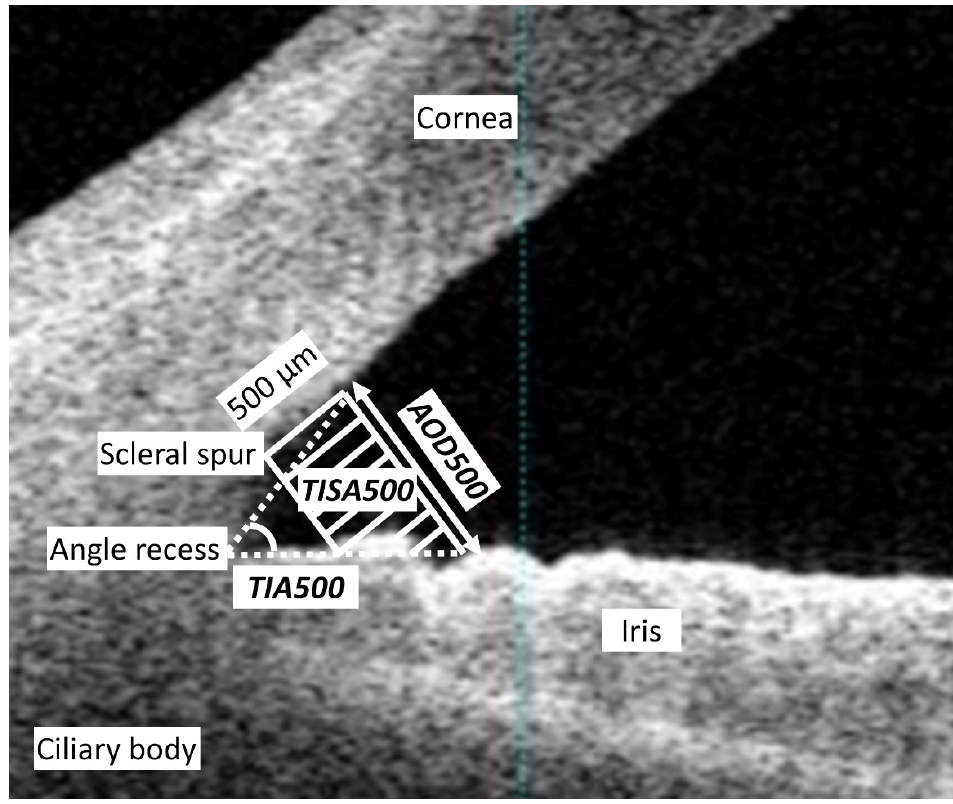
Figure 1. A schematic diagram of the angle opening parameters. AOD500 is the distance between the posterior cornea surface and the anterior iris surface measured on a line perpendicular to the trabecular meshwork at 500 µm from the scleral spur. TISA500 is the surface area of a trapezoid with the following boundaries: anteriorly, the AOD500 from the scleral spur; posteriorly, a line drawn from the scleral spur perpendicular to the plane of the inner scleral wall to the iris; superiorly, the inner corneoscleral wall; and inferiorly, the iris surface. TIA500 is a trabecular iris angle at 500 µm from the scleral spur.